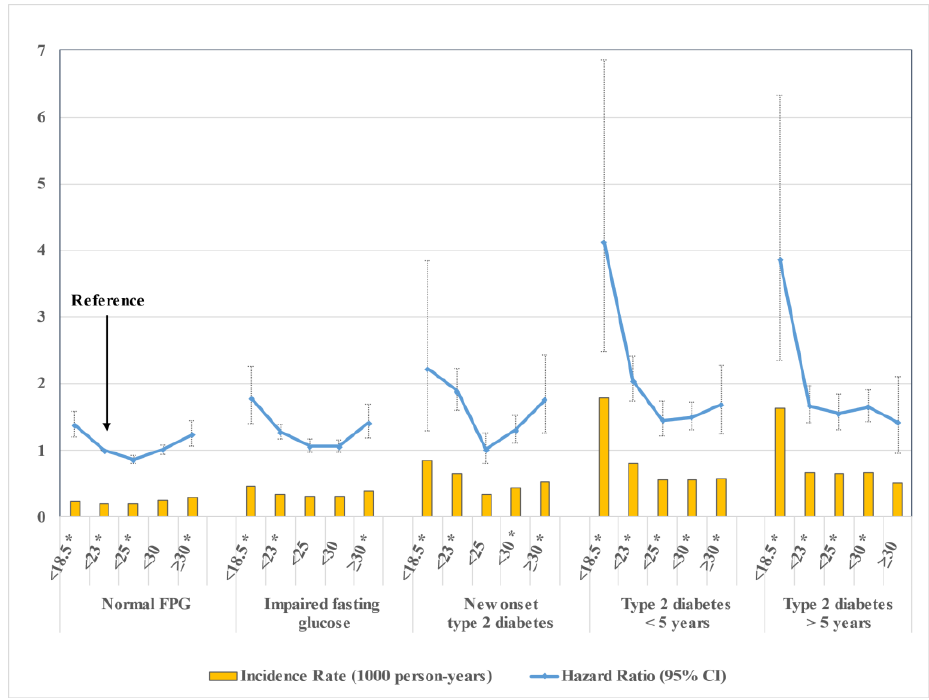
Figure 2. Incidence rates and adjusted hazard ratios of acute pancreatitis according to glycemic status and BMI category. Adjusted for age, sex, alcohol consumption, smoking, type 2 diabetes, insulin administration, hypertension, dyslipidemia, chronic kidney disease, chronic pancreatitis, regular physical activity, and low income. * Statistically significant.